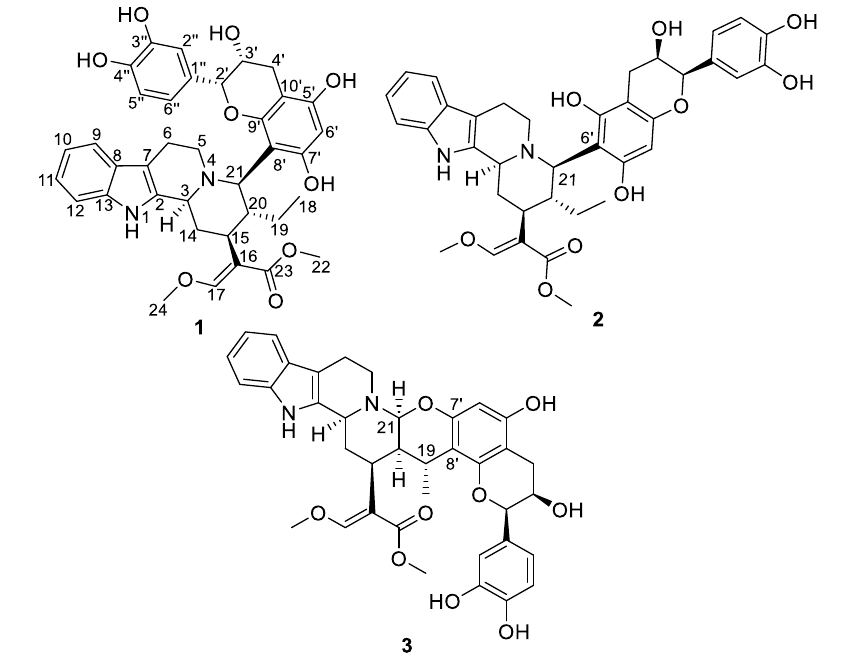
Figure 1. Chemical structures of compounds 1 – 3 .